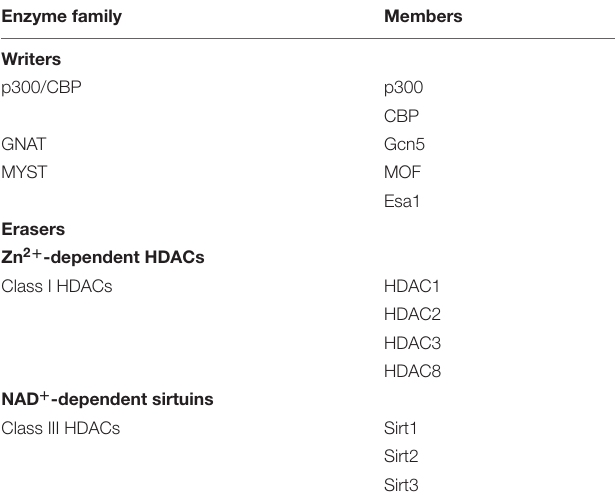
TABLE 2 | Writers and erasers of histone